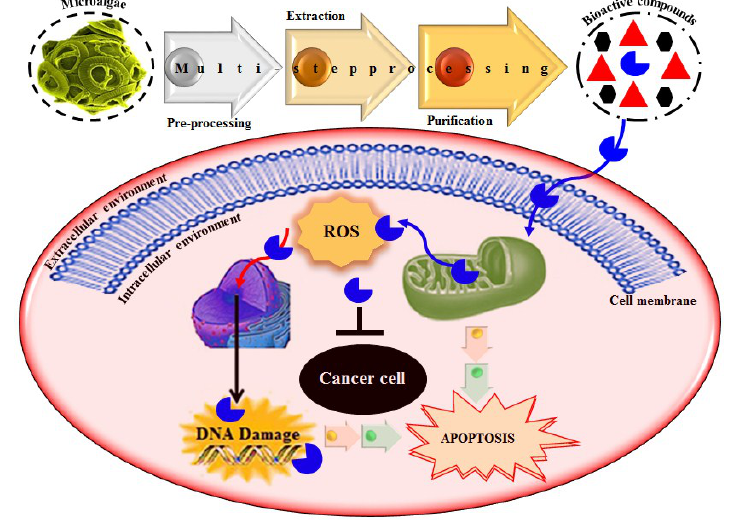
Figure 8. The proposed molecular mechanism bioactive compounds, e.g., fucoidans induced ROS-dependent apoptosis in a cancer cell. Reproduced from Centella et al. [9], with permission from Elsevier.